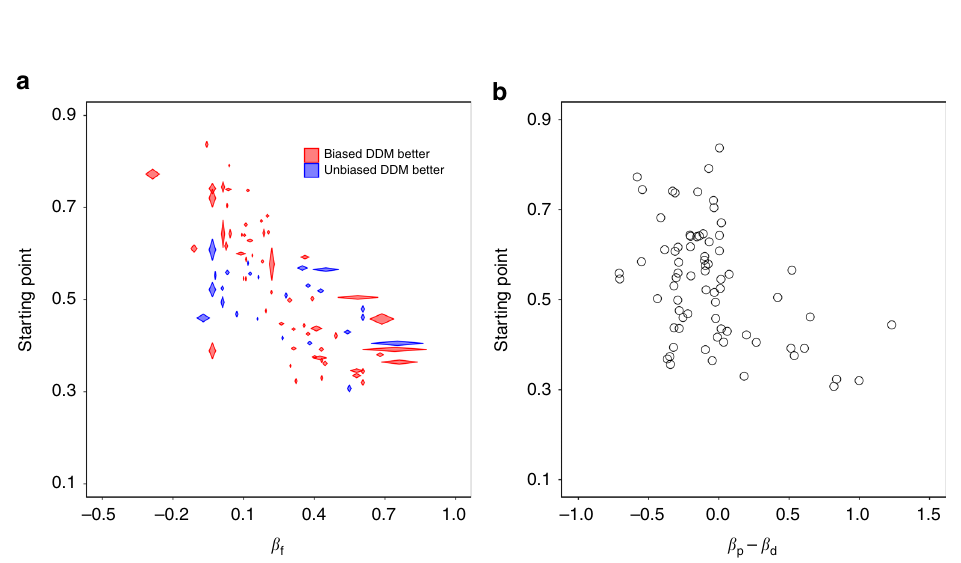
Fig. 6 Starting point plotted against β f and β p − β d . a Starting point vs. β f , and b starting point vs. β p − β d . Each diamond in a and each circle in b represents one subject. The length of the horizontal diagonal of each diamond in a represents the standard error (SE) of the β f , and length of the vertical diagonal represents the standard error of the starting point. Red represents subjects who were better fi t with the biased DDM, while blue represents subjects who were better fi t with the unbiased DDM. For illustration purposes, we constrain − 1 < β f < 1 and SE( β f ) < 0.3 for a (82 of 102 subjects), and we constrain β p and β d to [ − 1, 2] for b (73 of 102 subjects), but we included all the 102 subjects in the statistical